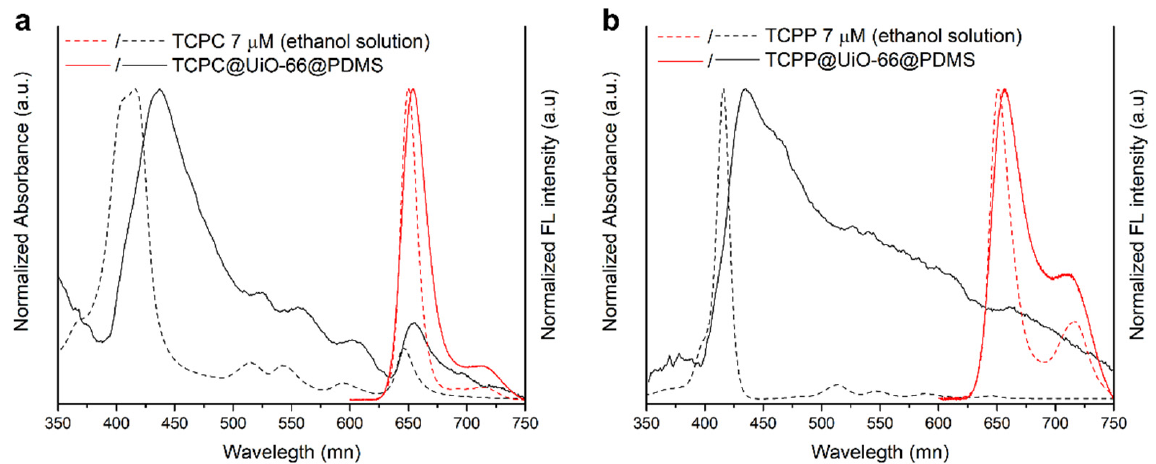
Figure 5. Absorbance (black lines) and FL emission (red lines) spectra of ( a ) TCPC@MOF@PDMS and ( b ) TCPP@MOF@PDMS films (solid lines) and the corresponding spectra of ( a ) TCPC and ( b ) TCPP in ethanol solution (dashed lines).